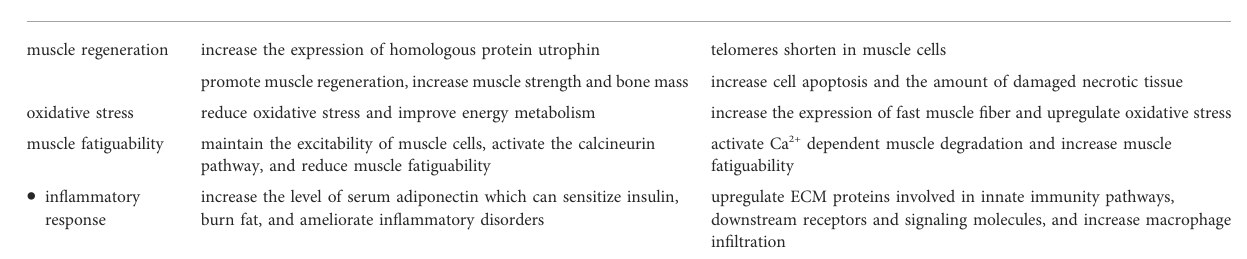
TABLE 1 A possible mechanism of action between beni fi cial and harmful exercise. Beni fi cial